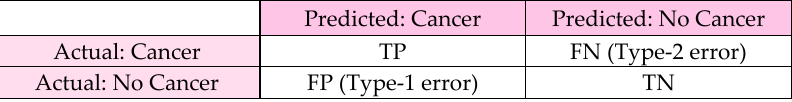
Figure 9. Confusion Matrix.